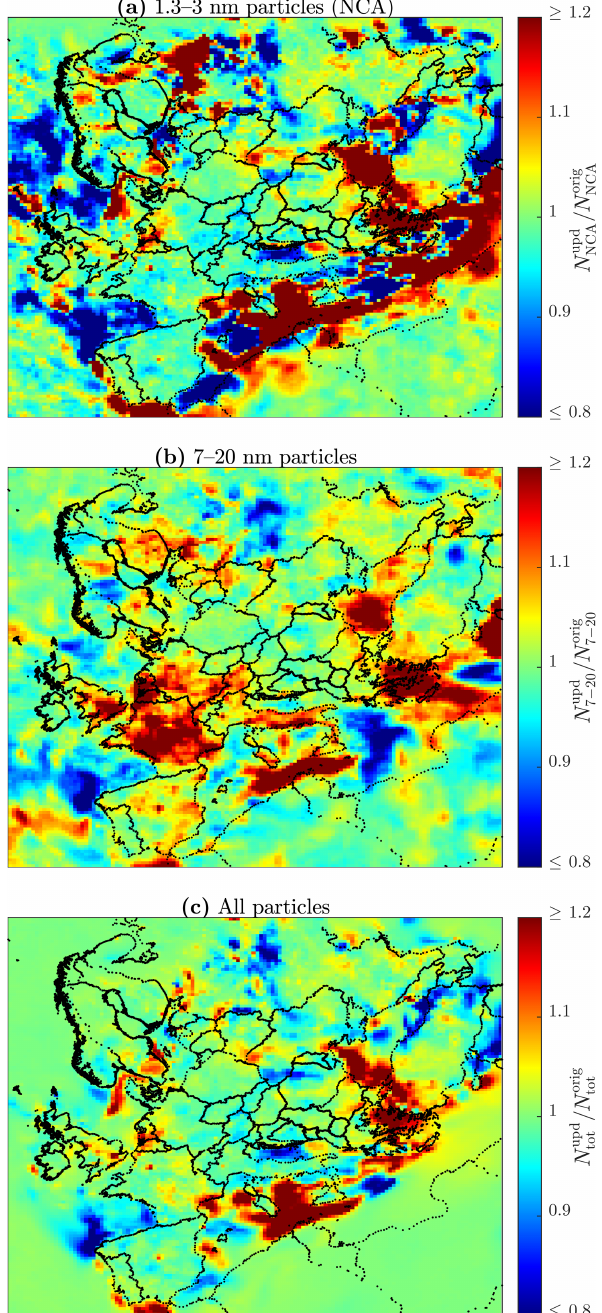
Figure 5. Ratios of monthly means of (a) the NCA concentration ( N NCA ), (b) the concentration of 7–20nm particles ( N 7 − 20 ), and (c) the total particle concentration ( N tot ) simulated with the updated and with the original emission